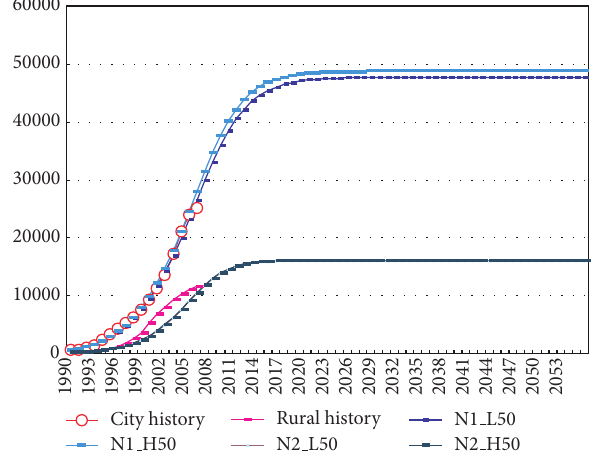
Figure 4: Plots of potential curve of telephone in rural area governed by model (67).